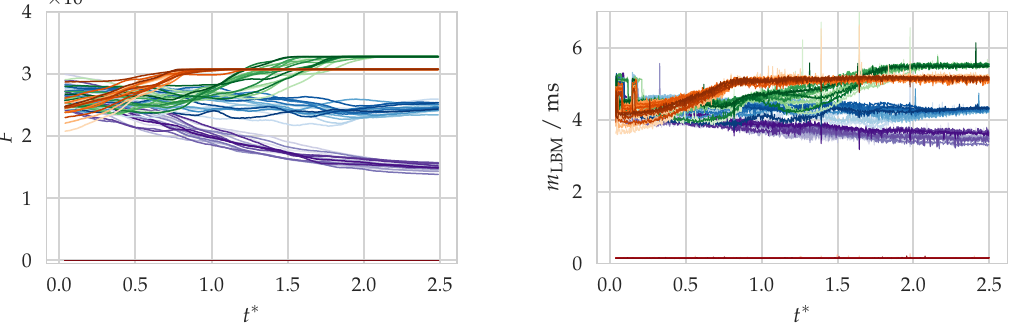
Figure 6. Number of fluid cells ( left ) and time measurements ( right ) of the LBM part per block over time ( t ∗ = t / T ) of the workload evaluation simulation with b s / ∆ x = 32 and D / ∆ x = 10. The coloring resembles the affiliation of the block to one of the five rows in the